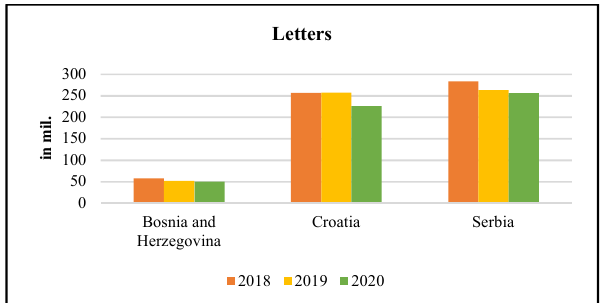
Figure 5. Letters -